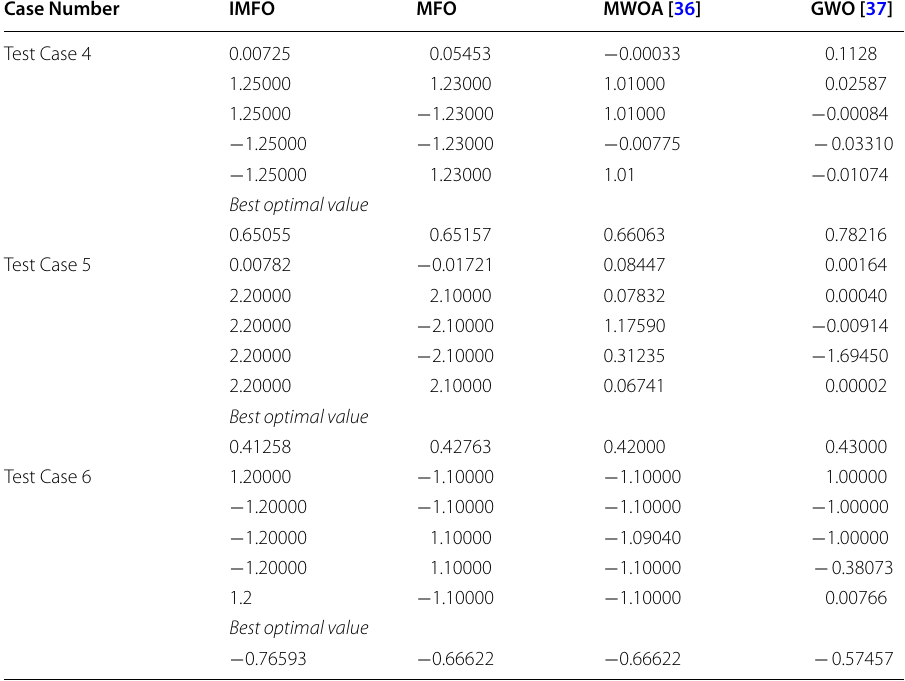
Table 2 Comparative analysis of three-phase transmission line parameters for inductance/length (mH) Case Number